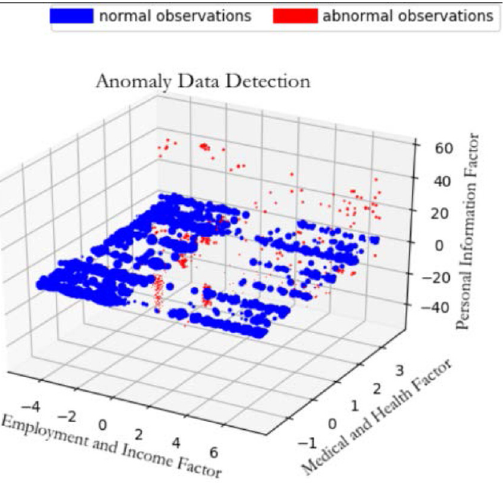
Figure 3. A visualization of anomaly data detection